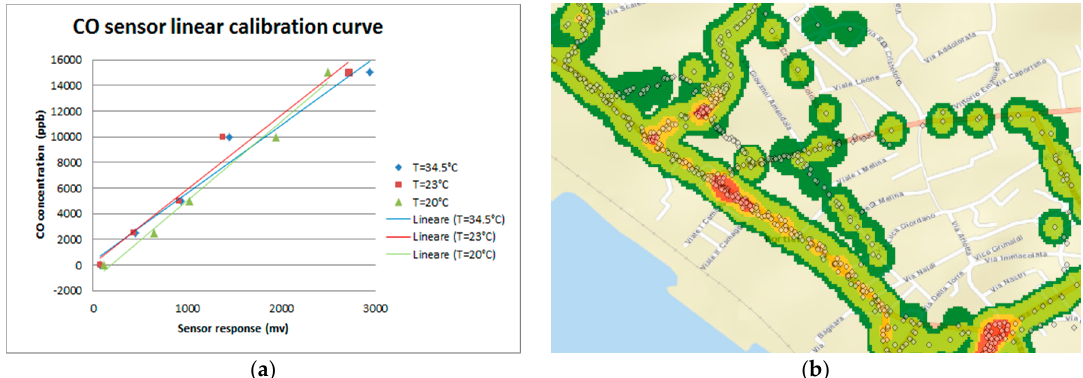
Figure 4. ( a ) CO sensor linear calibration curves at different temperatures; ( b ) time averaged pollution maps generated by preliminary experiments conducted in the city of Portici (NA), Italy. Red areas indicates significant pollution in areas usually affected by high car